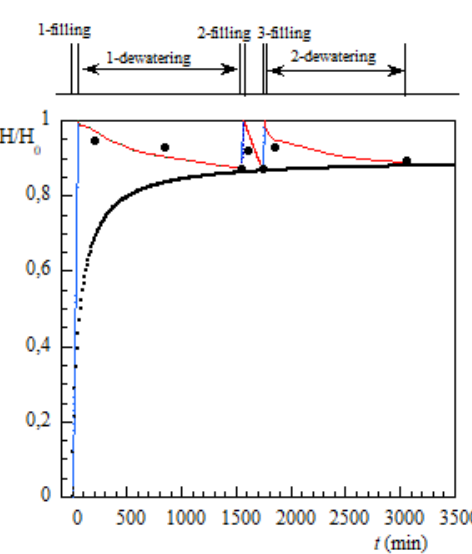
Figure 7. First three filling/dewatering stages of the process used to carry out the removal of Occhito reservoir. The dark dots are results of direct measurements on the geotextile tube.